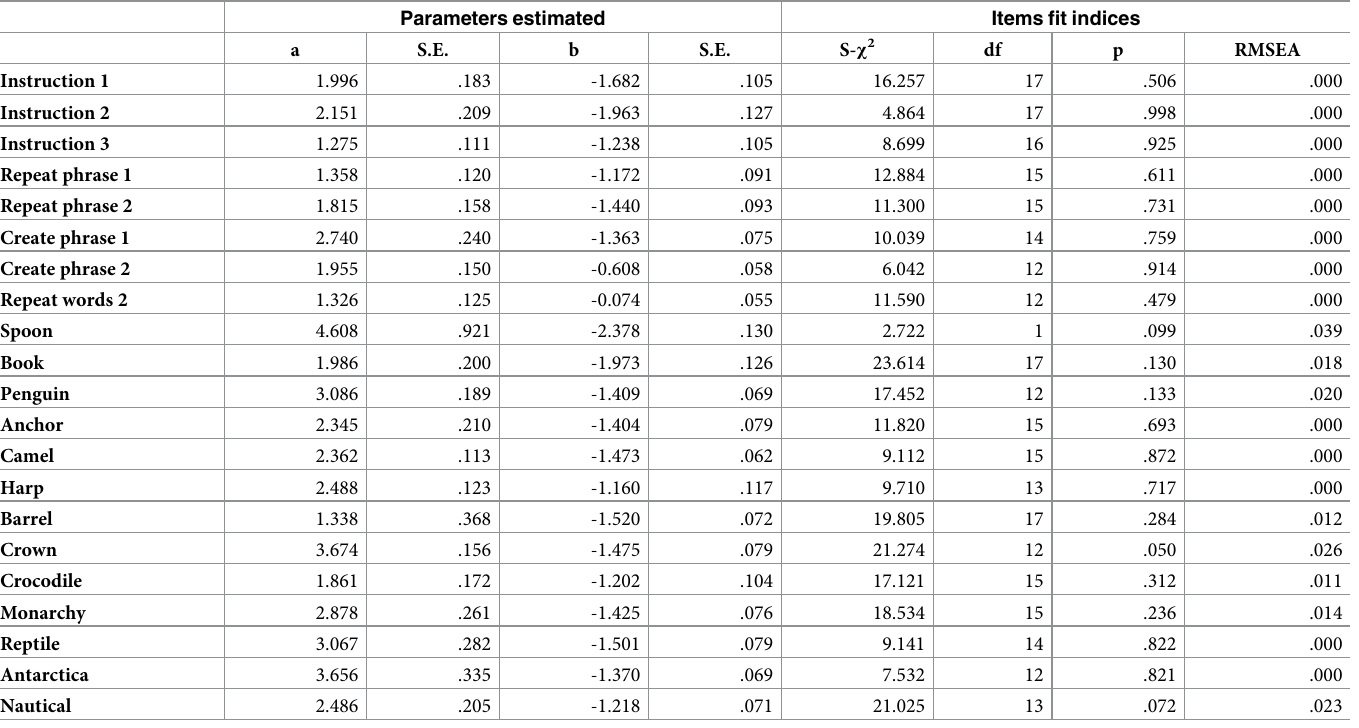
Table 6. Parameters estimated and item fit indices of proposed version of language